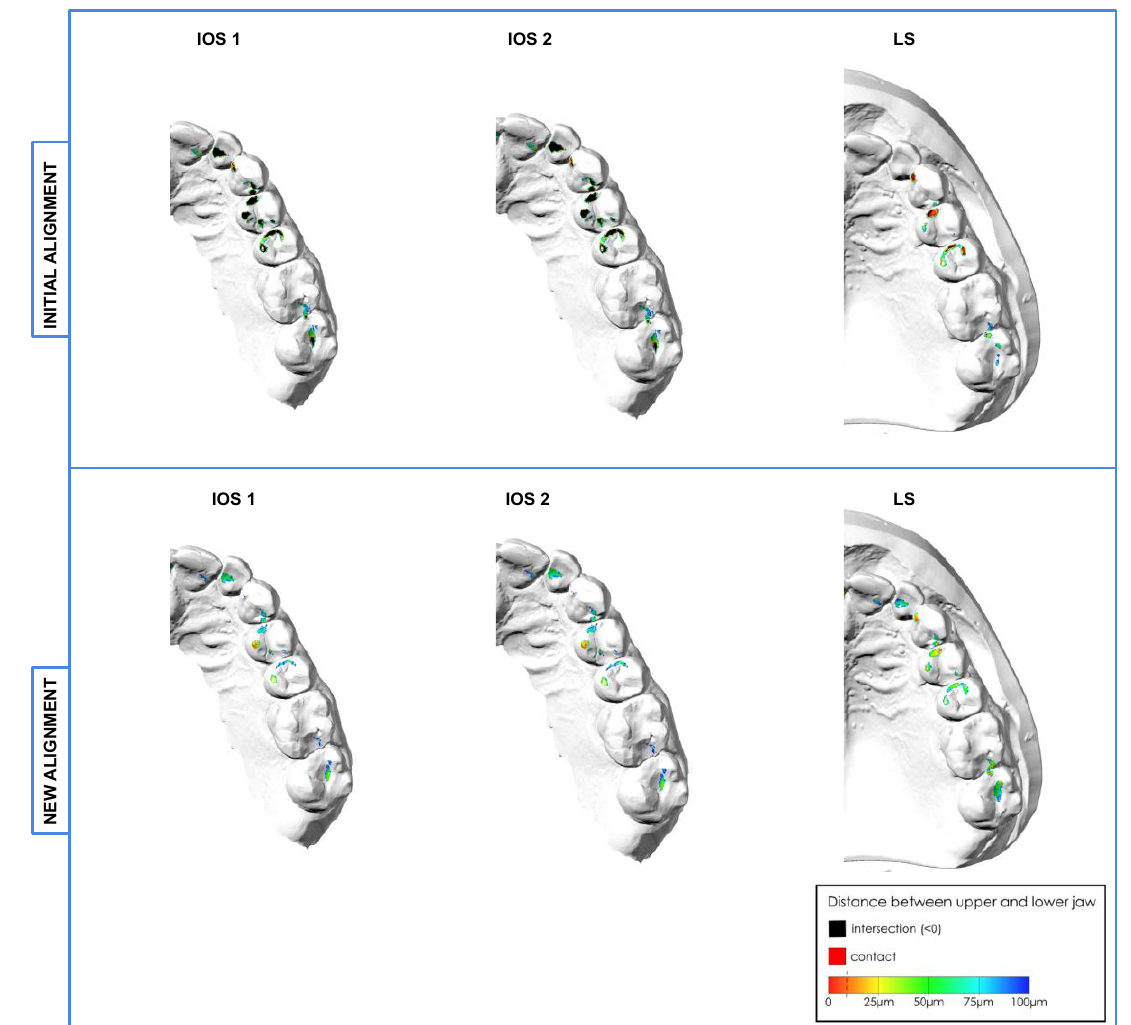
Figure 2. Distribution of occlusal contact points of initial and new alignments visualized by a colored distance map (interocclusal distance: max. 100 μ m).